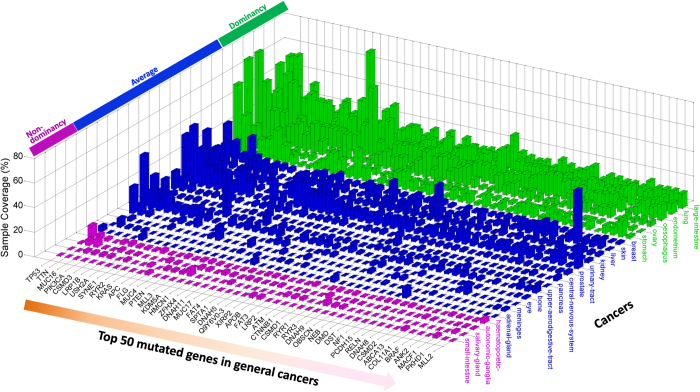
Most frequently mutated genes in general cancers.Shown are top 50 mutated genes for all cancer types detected in COSMIC v68. Cancers with at least one gene that muated in no less than 50% of the screened samples were termed ‘dominancy’ (right part); cancers with no gene mutating in more than 10% of the screened samples were termed as ‘non-dominancy’ (left part); the remainder were termed ‘average’ (middle part).